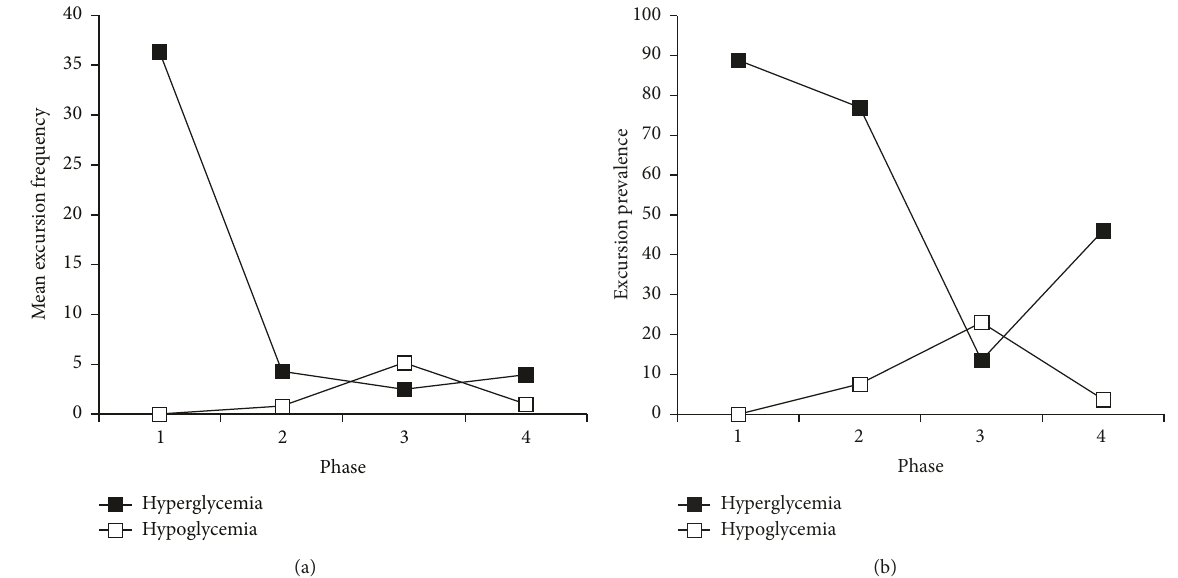
Figure 1: Glycemic excursions during each phase of therapeutic hypothermia. (Phase 1: initiation, Phase 2: hypothermia, Phase 3: rewarming, Phase 4: